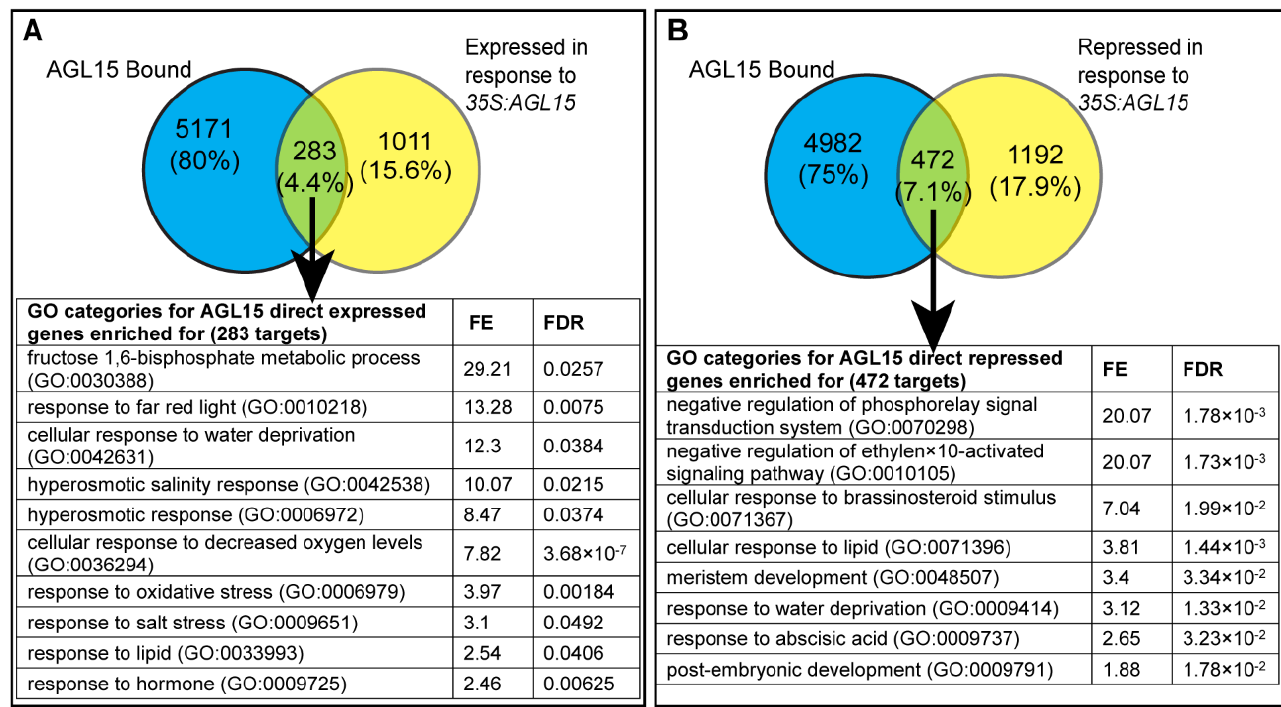
Figure 3. Overrepresented GO categories for genes associated with AGL15 by ChIP-Seq and respon- sive to AGL15 accumulation in 10 days after culture (dac) 35S:AGL15 SAM SE tissue compared to the wild type. ( A ) Direct induced and ( B ) direct repressed in response to AGL15. Details of the analysis are the same as in Figure 1. FE is fold enrichment compared to the whole Arabidopsis genome.